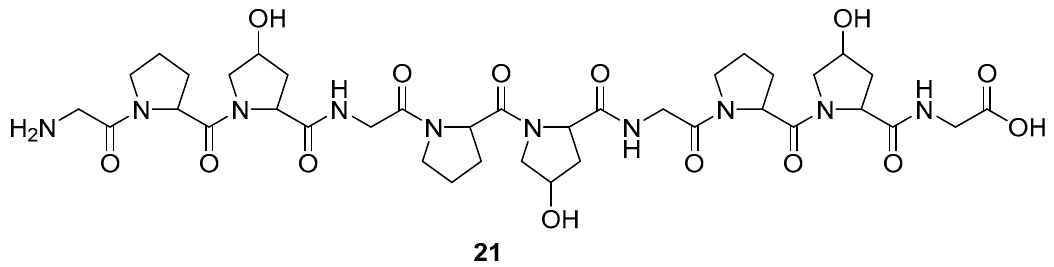
Figure 8. Structure of the Alaska Pollack collagen hydroxyl proline (APCHP) peptide ( 21 ).